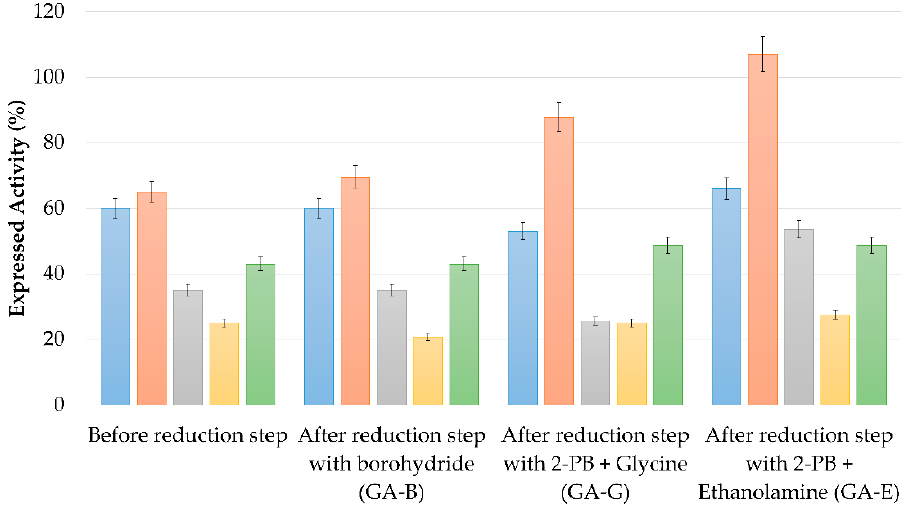
Figure 3. Expressed activities of the different conjugates before and after the reduction step. Expressed activity before reduction step (%) = (activity in the immobilized preparation before reduction)/(activity of the solution offered for immobilization – activity in the supernatant at the end of the immobilization process) × 100. Expressed activity after the reduction step (%) = (activity in the immobilized preparation after reduction)/(activity of the solution that is offered for immobilization − activity in the supernatant at the end of the immobilization process) × 100. Color code: ( ■ ) Xys1 Δ ; ( ■ ) ADH2; ( ■ ) GlyDH; ( ■ ) DAAO; ( ■ ) PGA. All of the data are the mean value of three separated experiments where the error value was never higher to 5%.